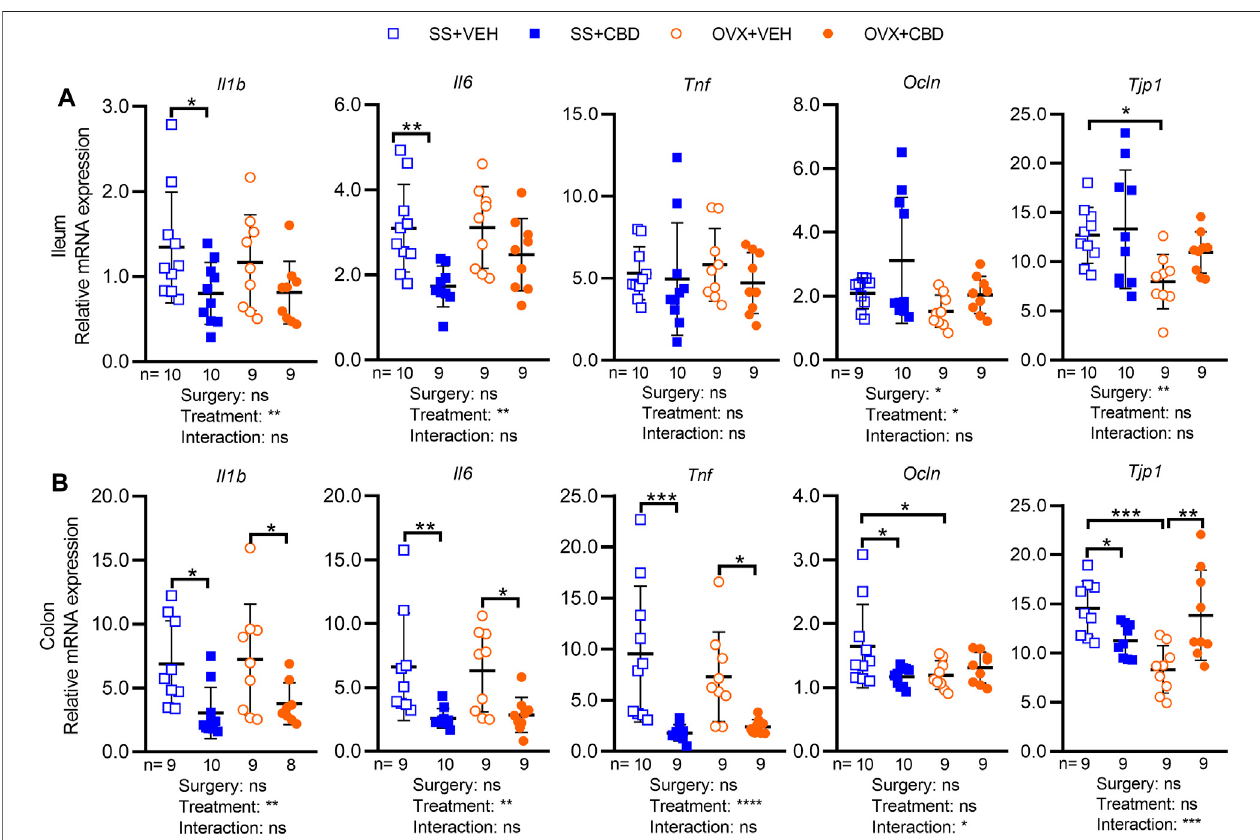
FIGURE2| CBDtreatment decreasedmarkersofintestinal in fl ammation.Geneexpressionlevelsofin fl ammatory markers(IL-1 β ,IL-6andTNF α )andtightjunction proteins (occludin and ZO-1) in (A) ileum and (B) colon collected from n = 9 mice in OVX groups and n = 10 mice in SS groups. All data are mean ± SD. The ROUT test was performed to detect outliers. Signi fi cant differences between groups were determined by two-way ANOVA followed by Holm-Sidak post-hoc test to isolate differences due to surgery or treatment, * p < 0.05, ** p < 0.01, *** p < 0.001.